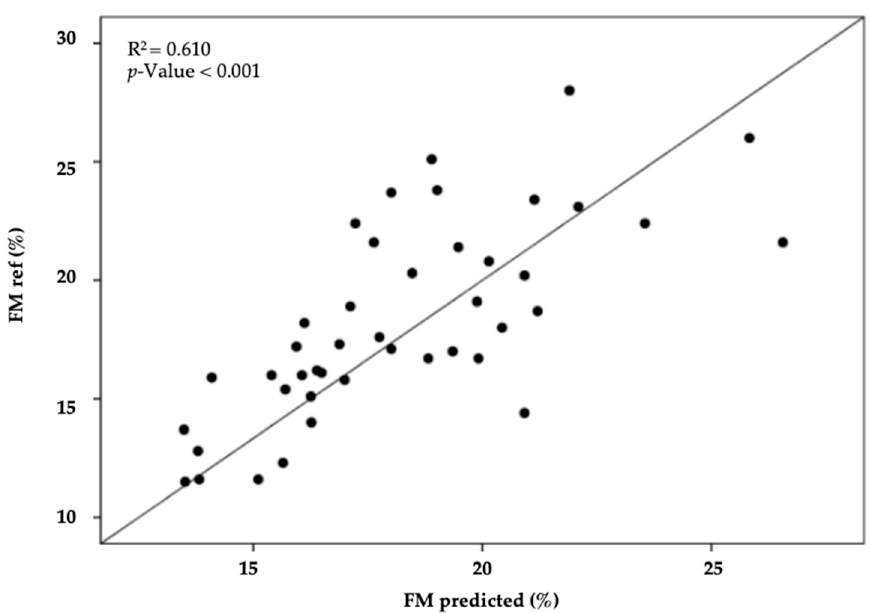
Figure 2. The scatter plot illustrates the results of the regression analysis for FM% obtained by the reference method (DXA) and predicted by the equation developed in the sample of international soccer referees.